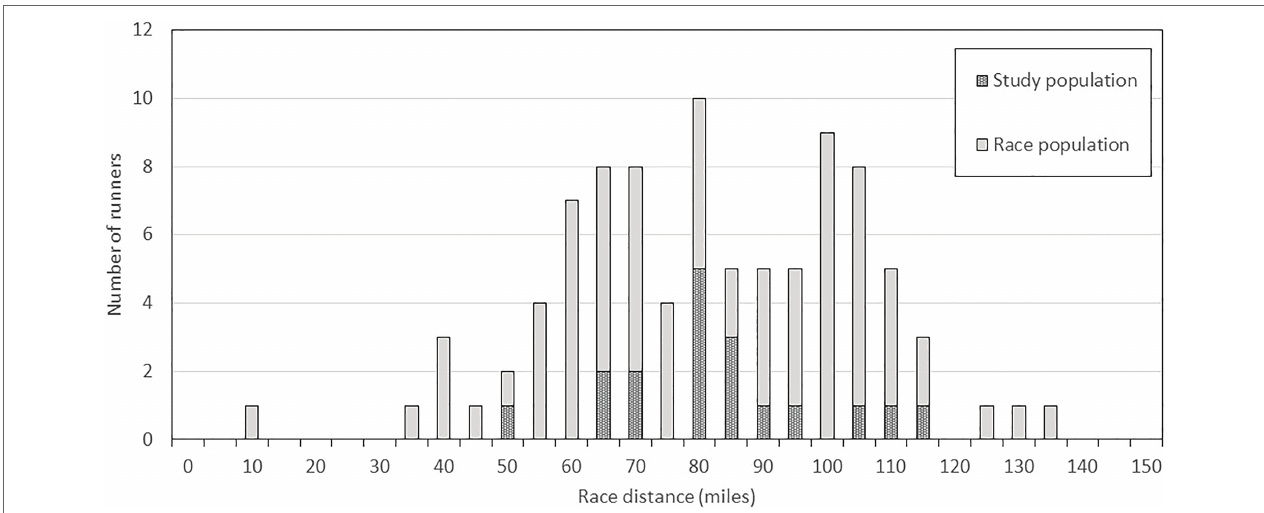
FIGURE 1 | Histogram showing the spread of study participants across the G24 race population highlighting a representative sample of